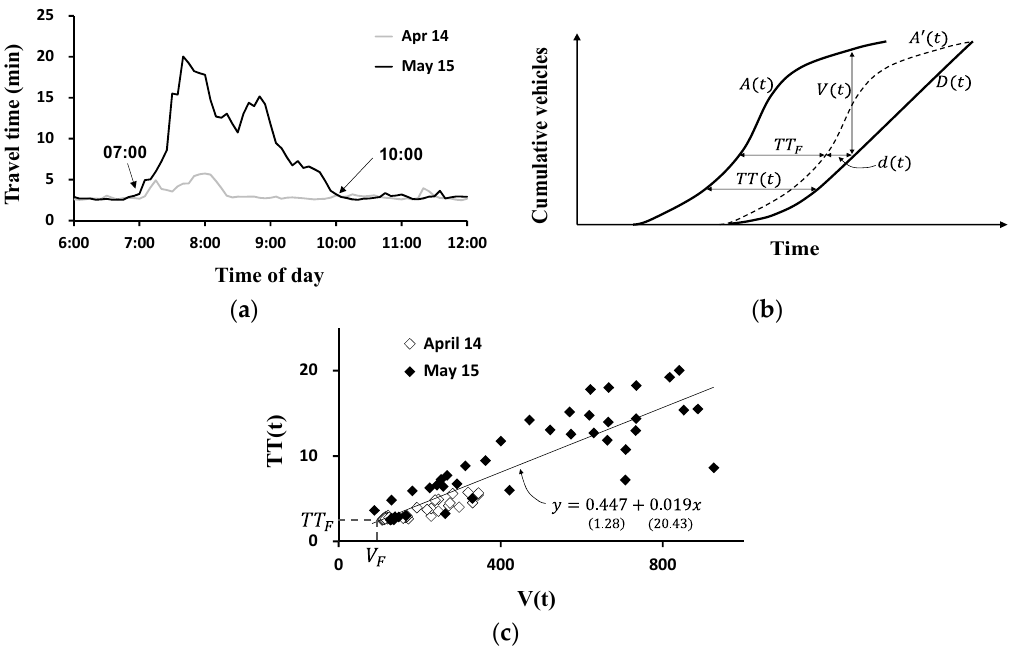
Figure 4. ( a ) Segment travel times reported by INRIX. ( b ) Input–output diagram using the traffic count data from the toll plaza and segment travel times. ( c ) Relationship between cumulative count of vehicles and segment travel times from before and after period (the numbers in parentheses are t -value of parameters).